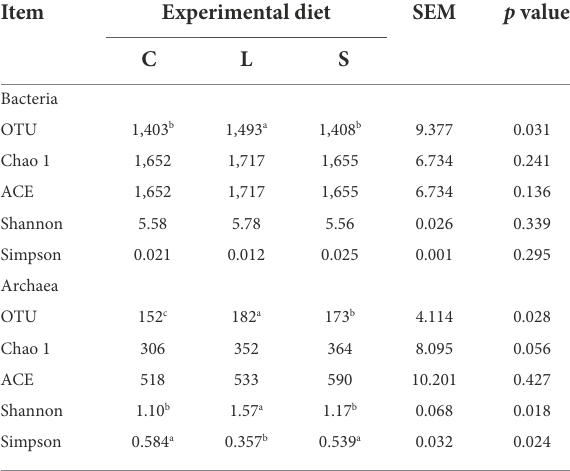
TABLE 4 Effect of two glucogenic (C, S) and a lipogenic (L) diet on the alpha diversity indices of ruminal bacteria and archaea communities after 48 h in vitro fermentation with rumen fluid of dairy